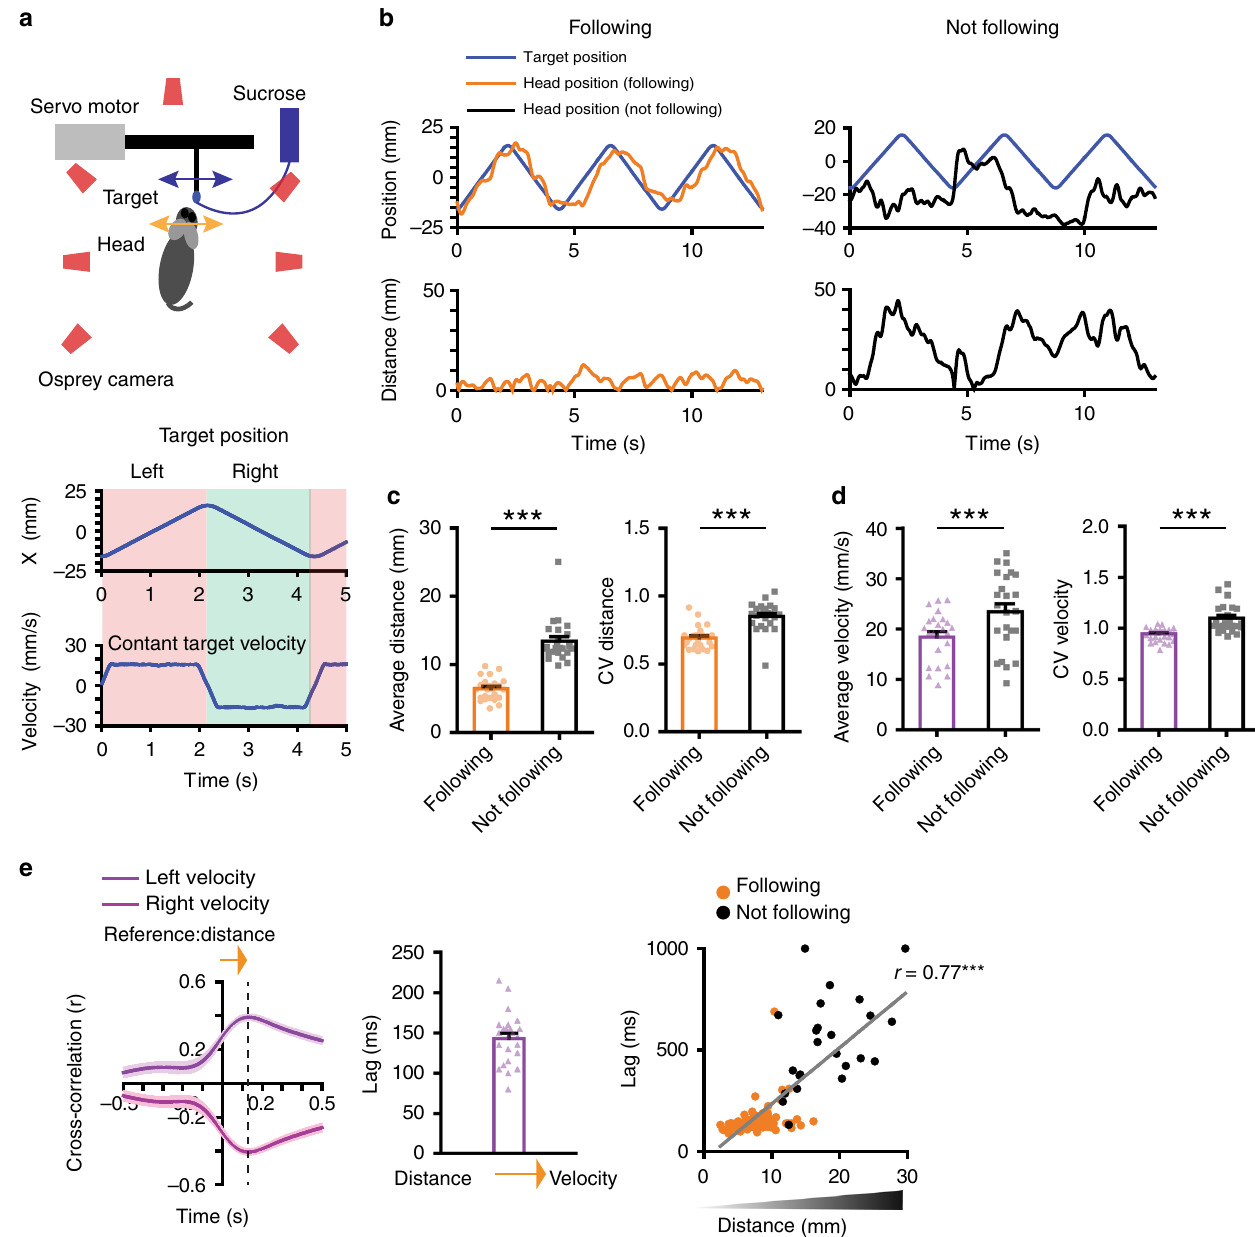
Fig. 1 Summary of behavioral results. a Top, illustration of the pursuit task and location of the infrared cameras for 3D motion capture. The target moves continuously from side to side, each cycle consisting of both leftward and rightward movements. During pursuit, the target could be on either side of the mouse. Bottom, position and velocity traces of the target, which moves along the x -axis at a constant velocity of 16 mm/s (see extended Fig. 1 for variable velocity condition). The total distance traveled from left to right is 32 mm. Thus, it takes the target ~2 s to move from one extreme to another. b Representative traces of mouse head and target position. Left panel shows the head and target positions during ‘ Following ’ . ‘ Following ’ is de fi ned as a period in which the head is close to the target (<15 mm × -axis, <10 mm in y -axis, <20 mm in z -axis). Right panel shows the head and target positions during ‘ Not following ’ . Also see Supplementary movies 1 and 2 for examples. c Average distance is signi fi cantly reduced during following (paired t -test, p < 0.0001). Coef fi cient of variation (CV) in distance shows that variance is also increased when animals are not following. d Average self-velocity is signi fi cantly lower during following (paired t -test, p < 0.0001). CV in velocity is also increased when animals are not following. e Illustration of the temporal relationship between distance and self-velocity. Cross-correlation analysis reveals the lag between these two variables, showing that distance leads self- velocity during pursuit behavior. In addition, the lag shows a positive correlation with distance ( p < 0.0001). When the mouse is actively pursuing and maintaining a small distance, the lag between distance and velocity is small, but the lag increases as pursuit performance declines. Error bars indicate ± s.e.m. *** p < 0.0001. Source data are provided as a Source Data fi le in PV + neurons (PV-Cre) 21 . Only neurons that are activated by FSIs (Fig. 4a, b). More importantly, most identi fi ed FSIs are also light stimulation with a short latency (<8 ms) are classi fi ed as correlated with distance to target (Fig. 4c – e). The population FSIs (Supplementary Table 5). The optogenetically tagged cells average activity shows a highly linear relationship with distance show similar waveforms and fi ring rates as those we classi fi ed as (Fig. 4f). NATURE COMMUNICATIONS| (2019) 10:2715